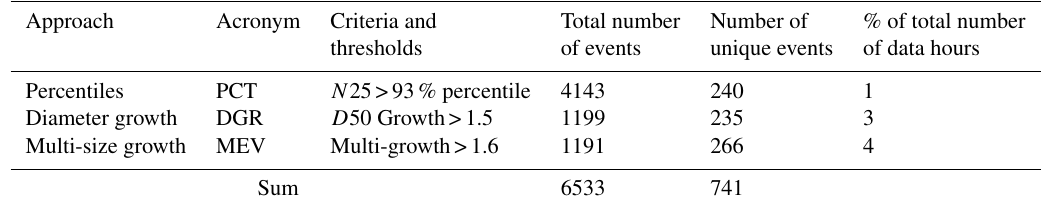
Table 2. Total and unique number of events of new particle formation identified by the three approaches to identify NPF events, and percent of all data hours covered by unique